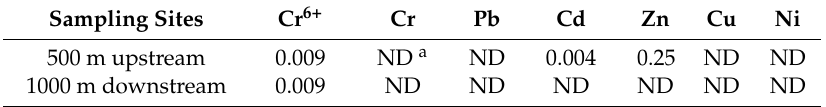
Table 4. Toxic metal concentrations of surface water in Xiangjiang River